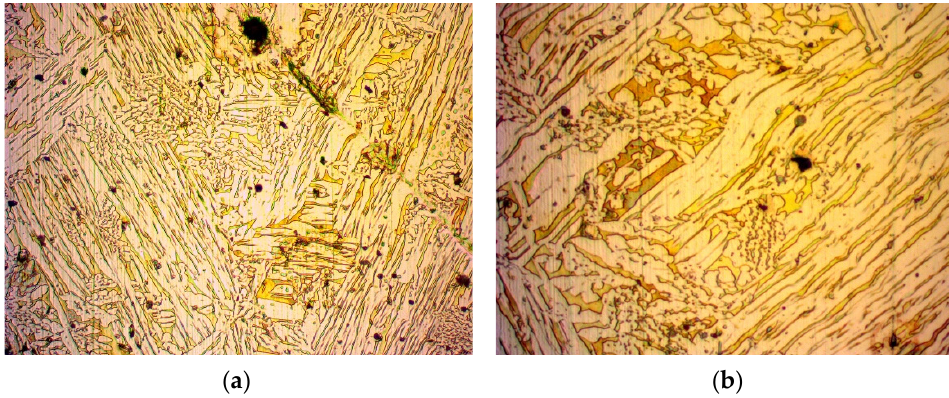
Figure 5. Specimen 3: Image from optical microscope after metallography of work-hardened in steps brass alloy: ( a ) magnification ×500; ( b ) magnification ×1000.